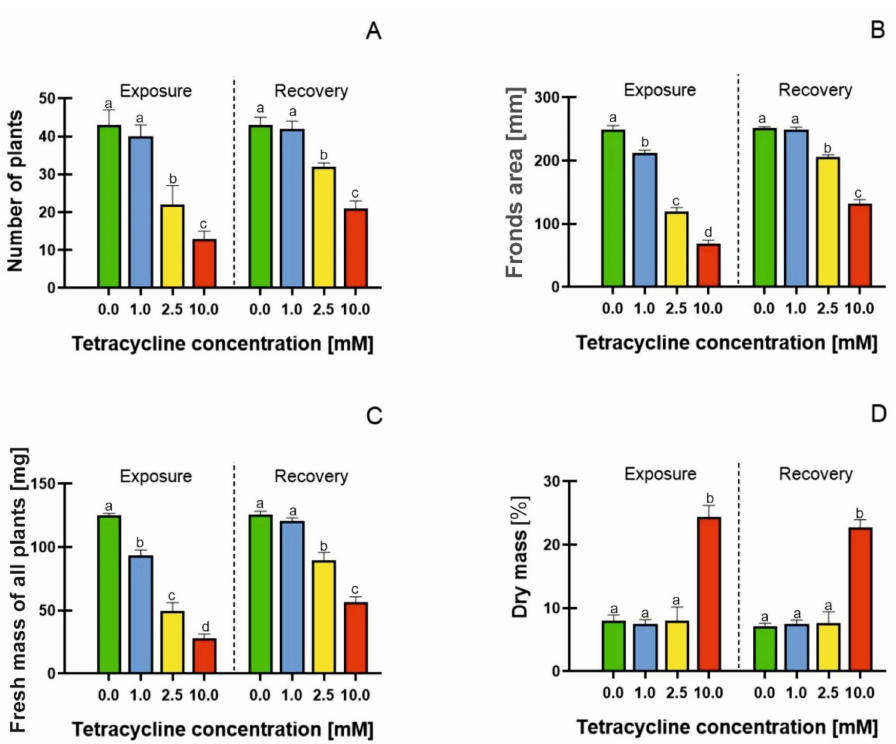
Figure 1. Growth parameters: number of plants ( A ), frond area (mm) ( B ), fresh mass of all plants (mg) ( C ), dry mass (%) ( D ) in Lemna minor subjected to tetracycline and in the recovery (resumed growth after 7 days of culture in antibiotic-free medium). Means denoted with different letters are significantly different ( p ≤ 0.05) across the described groups: average ± standard